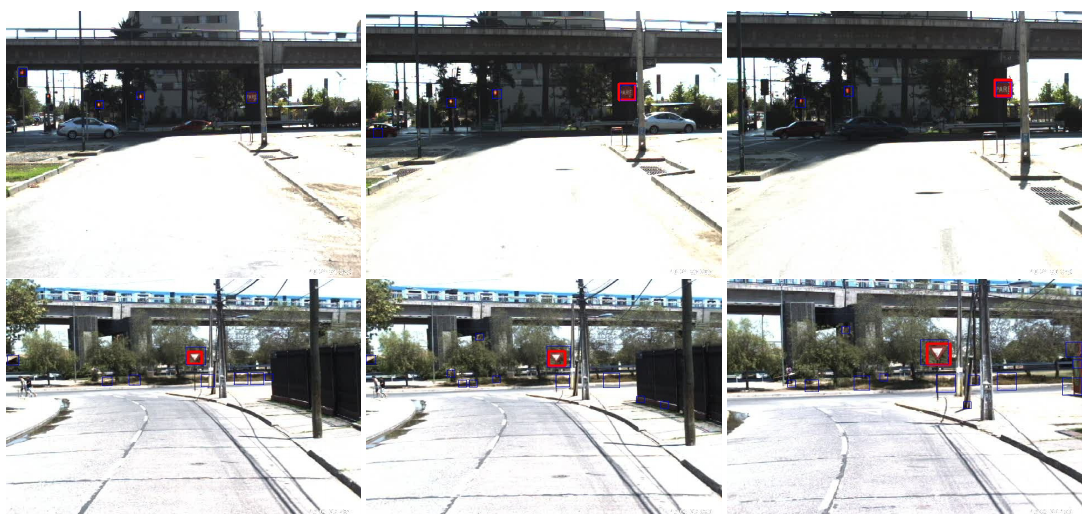
Figure 14. Example of the proposed system in different instants of time, in daytime conditions. Stop sign ( Top ) and Yield sign ( Bottom ), where blue indicates the ROIs and red shows the true